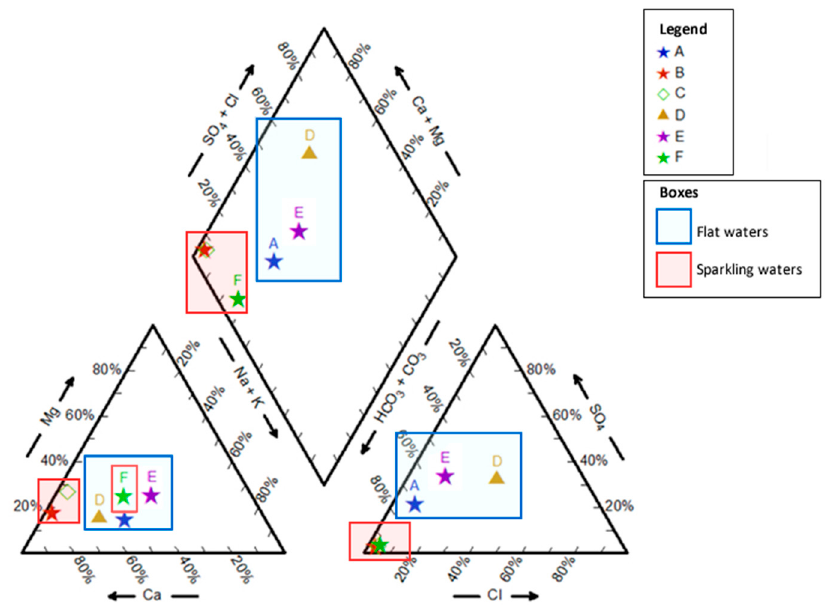
Figure 1. Classification results of the six mineral bottled water brands examined using the Piper diagram. The data elaboration consented to the association between the majority of chemical and physical indicators (calcium, magnesium, sodium, potassium, bicarbonates, sulfates, chlorides). Results of parameters not shown in the Piper are available in Table S1 in Supplementary Materials.